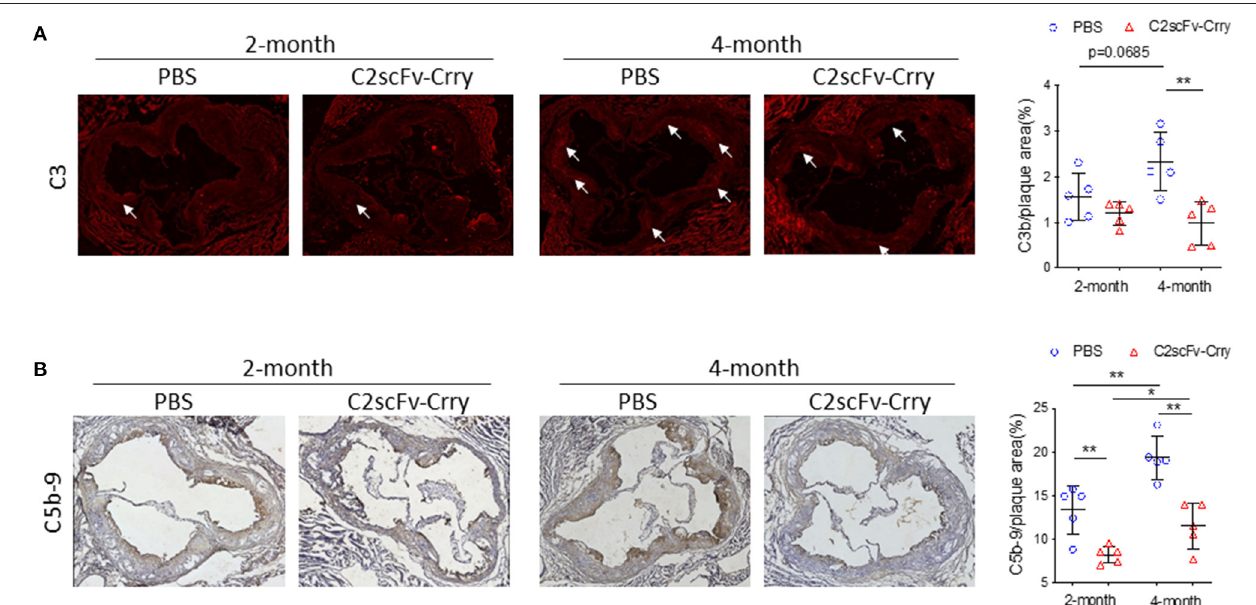
FIGURE 3 | C2scFv-Crry attenuates complement activation in the plaque of Apoe − / − mice. (A) Representative C3b (left) staining in the aortic root from Apoe − / − mice treated with PBS or C2-Crry and quantification of C3b positive area in plaque (right). (B) Representative C5b-9 (left) staining in the aortic root from Apoe − / − mice treated with PBS or C2-Crry and quantification of C5b-9 positive area in plaque (right) (* p < 0.05, ** p < 0.01 using unpaired Student’s t -test).